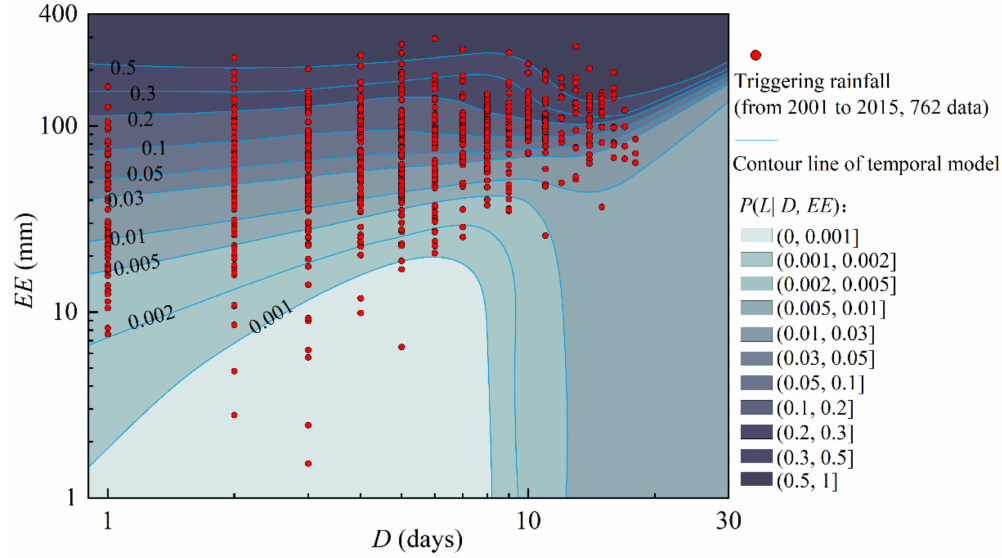
Figure 11. Contour lines of the landslide temporal probability in the D–EE